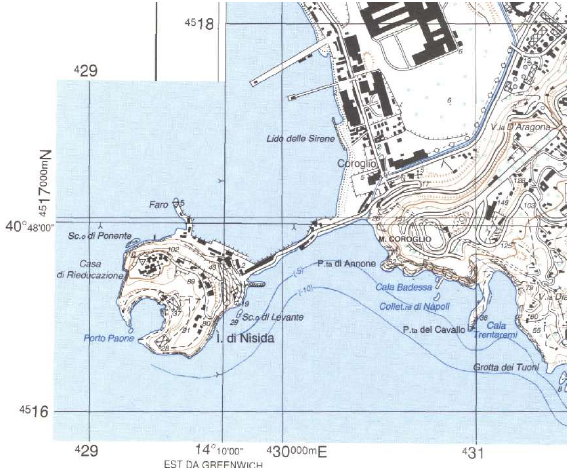
Figure 3. A detail of the Topographic Map n° 447-II, produced by IGMI: the isle of Nisida (between Naples and Pozzuoli).